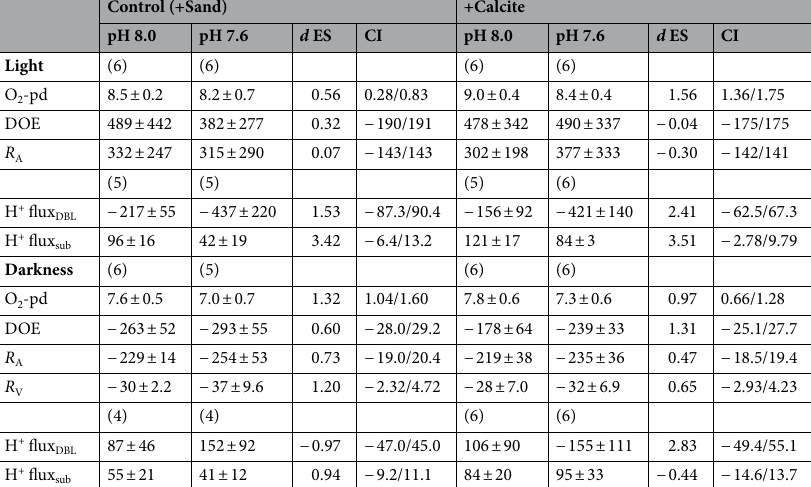
Table 2. Effects of seawater CO 2 enrichment and calcite deposit on the silt’s average (± 1 SD) O 2 consumption, porewater oxygenation, and H + flux. O 2 -pd, O 2 penetration depth (mm); DOE, diffusive O 2 exchange (μmol vertical [H + ] gradients in the diffusive boundary layer and at the bottom 2 mm of the oxic layer, respectively. Negative and positive DOE, R or H + flux values indicate sediment solute uptake and release, respectively. The d Effect size ( d ES) and 95% confidence intervals (CI) refer to pH 8.0 (ambient) versus pH 7.6 (CO 2 -enriched) comparisons. Numbers in parenthesis are number of replicate measurements